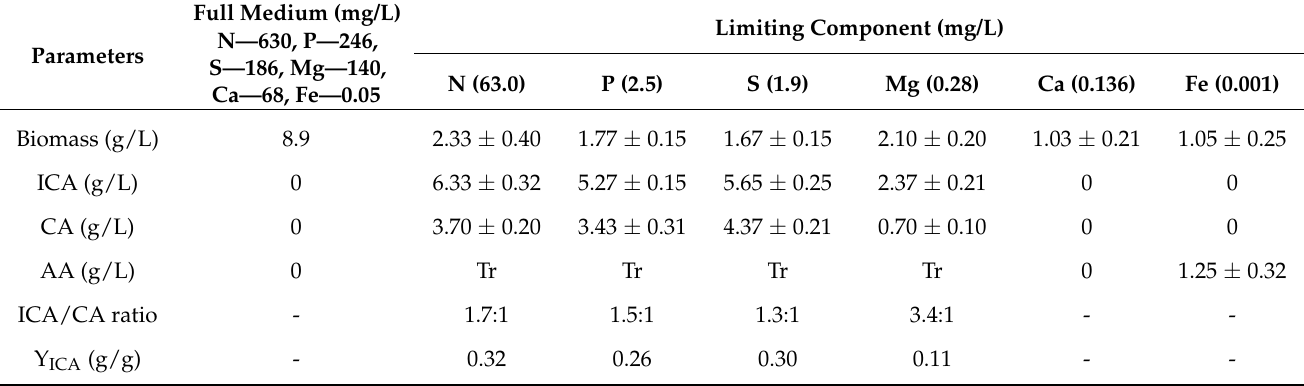
Table 2. Effect of limiting component on the growth of Y. lipolytica VKM Y-2373 and ICA production.